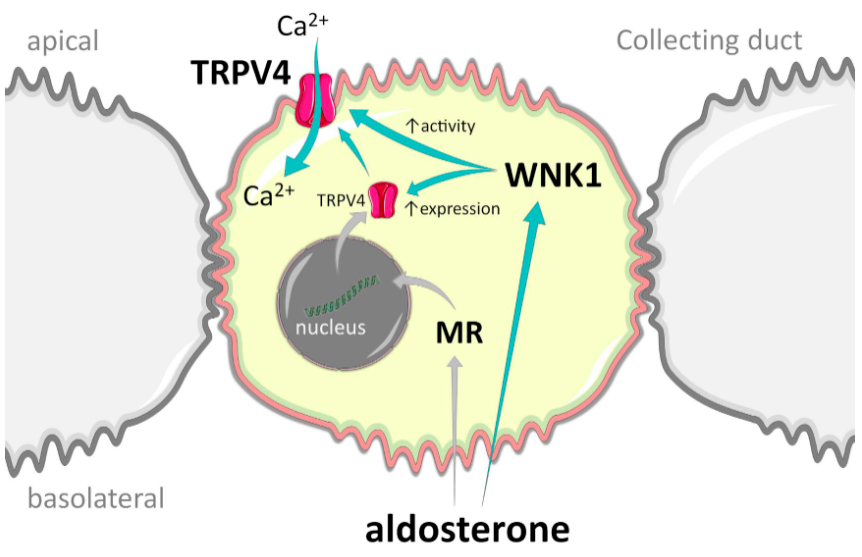
Figure 9. Principal scheme of TRPV4 regulation by WNK1 in the collecting duct cells. Green arrows represent stimulatory actions. MR—mineralocorticoid receptors.